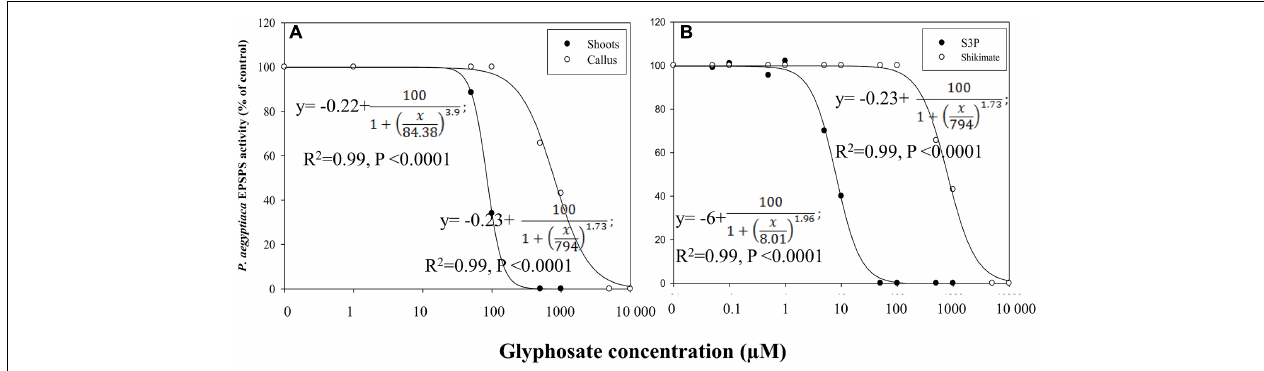
FIGURE 7 | Influence of glyphosate on EPSPS activity of P. aegyptiaca . (A) Flowering shoots and callus with shikimic acid as substrate. (B) EPSPS activity extracted from P. aegyptiaca callus with shikimic acid and shikimate-3-phosphate (S3P) as substrates. The experiment was conducted with four replicates per treatment. Data were computed by non-linear regressions using Sigma-Plot version 11.01. y = y 0 + 100 ; (A) For flowering shoots: R 2 = 0.99, P < 0.0001, 1 + ( x 8 . 01 ) 1 . 96 a = 100, b = 3.90, x 0 = 84.38, y 0 = –0.02; for callus: R 2 = 0.99, P < 0.0001, a = 100, b = 1.73, x 0 = 794, y 0 = –0.23. (B) For shikimic acid as substrate: P < 0.0001, a = 100, b = 1.73, x 0 = 794, y 0 = –0.23; for S3P as substrate: P < 0.0001, a = 100, b = 1.96, x 0 = 8.01, y 0 = –6.00. Data were arcsine-transformed before analysis. On the graphs, back-transformed means are